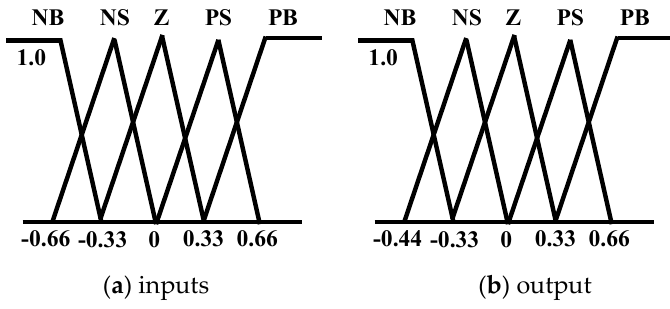
Figure 7. Membership functions of an FLC.